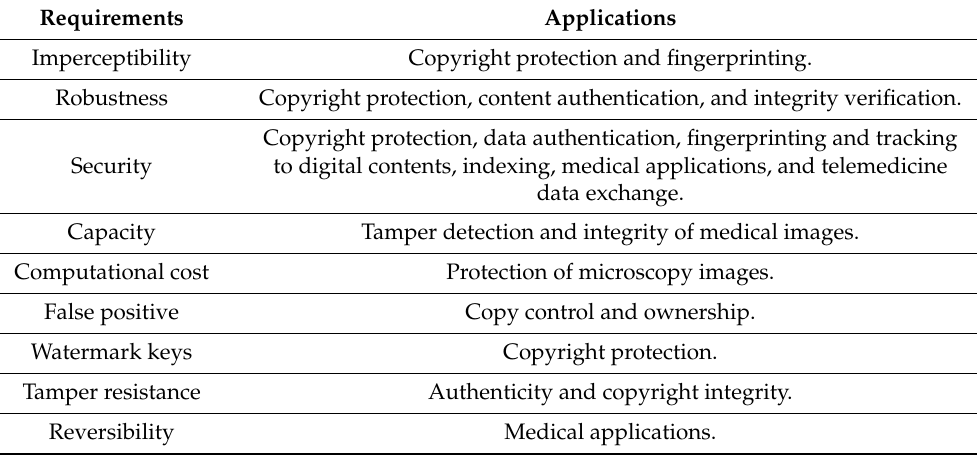
Table 2. Design requirements and their corresponding applications.